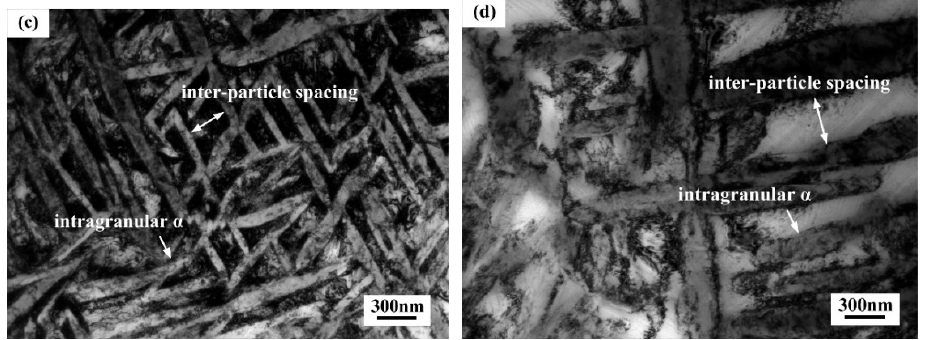
Figure 6. TEM micrographs of intragranular α in the alloy aged at ( a ) 480 ◦ C; ( b ) 520 ◦ C; ( c ) 560 ◦ C ( d ) 600 ◦ C for 4 h.